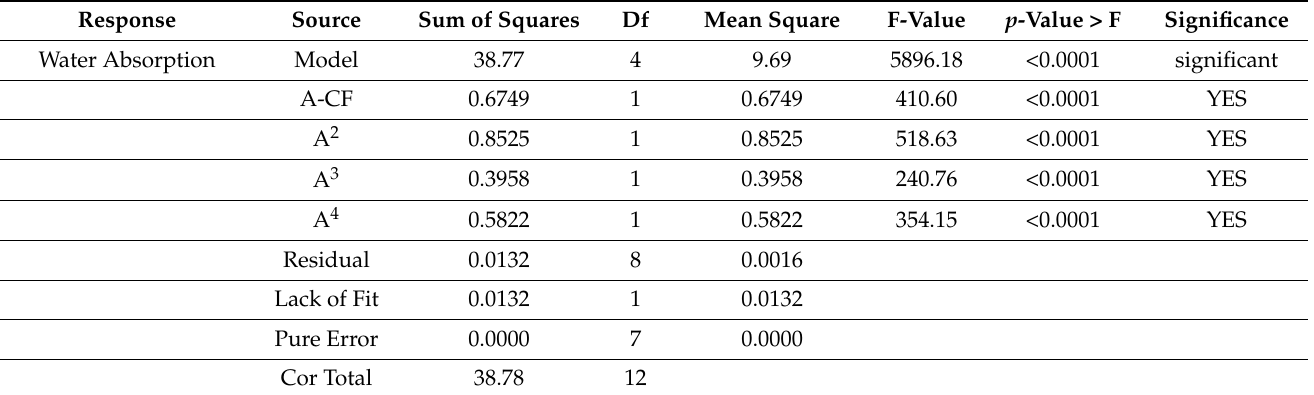
Table 8. ANOVA Results for the Variable Response 28-day Water